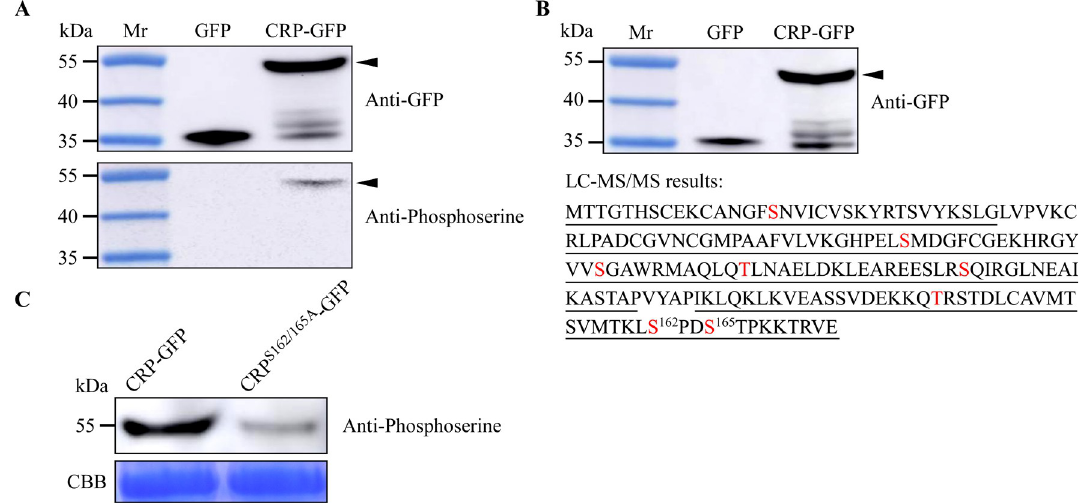
Fig 1. Identification of phosphorylation sites in CWMV CRP through LC-MS/MS. A. In vivo phosphorylation of CRP. Total protein was extracted from the protoplasts expressing GFP or CRP-GFP, and then analyzed through immunoprecipitation using an anti-GFP or an anti-phosphoserine antibody. B. Detection of CRP-GFP purified from the inoculated protoplasts using western blot (upper panel). The LC-MS/MS result is shown in the lower panel. The underlined CRP amino acid sequence was identified in this study through LC-MS/MS, and the phosphorylation sites in this protein are shown in red. C. The phosphorylation levels of CRP-GFP and CRP S162/165A -GFP were determined through western blot analysis using a phosphoserine specific antibody. The CBB-stained gel is used to show sample